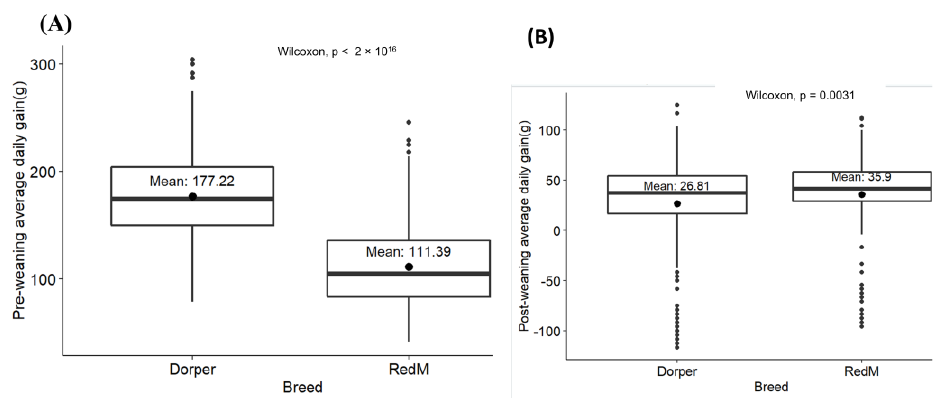
Figure 3. Comparison of average growth rate. ( A ) Pre-weaning growth rate; ( B ) post-weaning growth rate. The point inside the box plot shows the overall mean for the specific breed. Additionally, the p values are shown on the upper side of the figure.